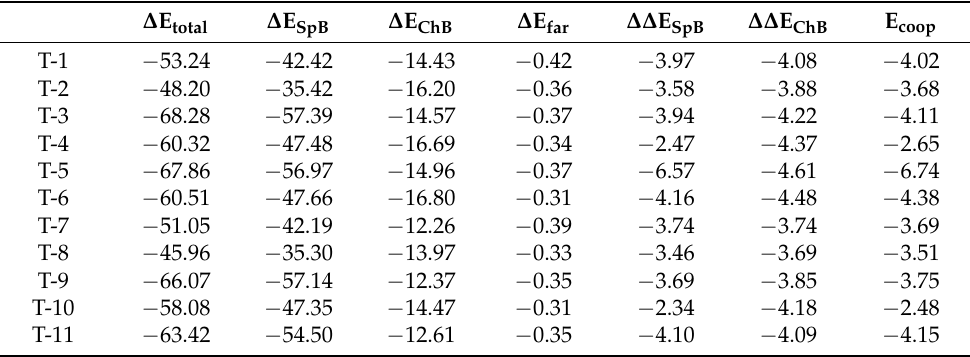
Table 6. Total interaction energy ( ∆ E total ), interaction energy between molecular pairs ( ∆ E), and cooperative energy (E coop ) in the ternary complexes, all in